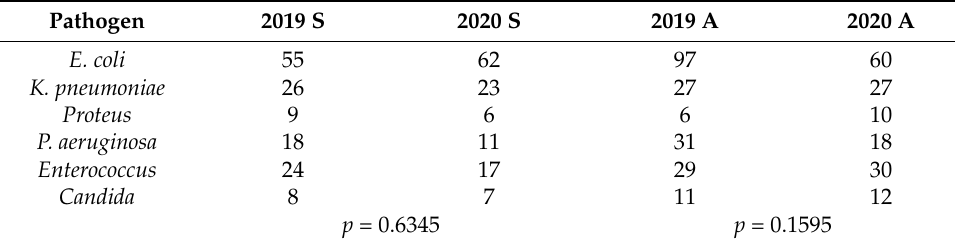
Table 4. Pathogens found in urine cultures.